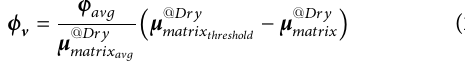
Frontiers in Earth Science |